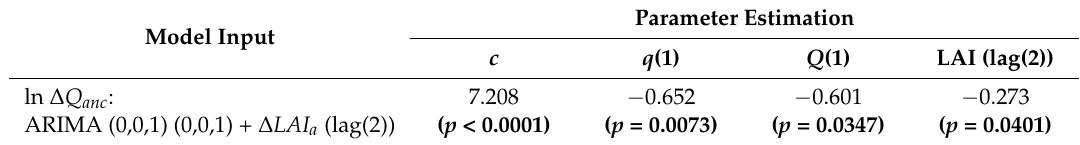
Table 5. ARIMAX (Autoregressive Integrated Moving Average) model structure and parameters.